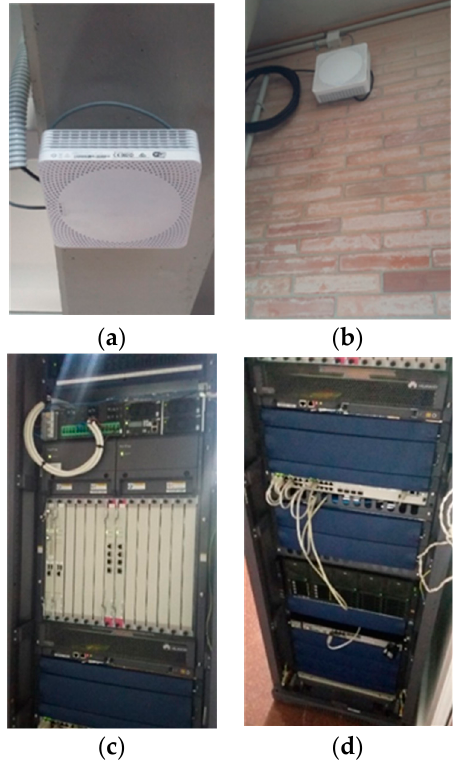
Figure 6. UMAHetNet equipment captures: deployed picocells ( a )( b ) and UMAHetNet’s EPC ( c )( d ).